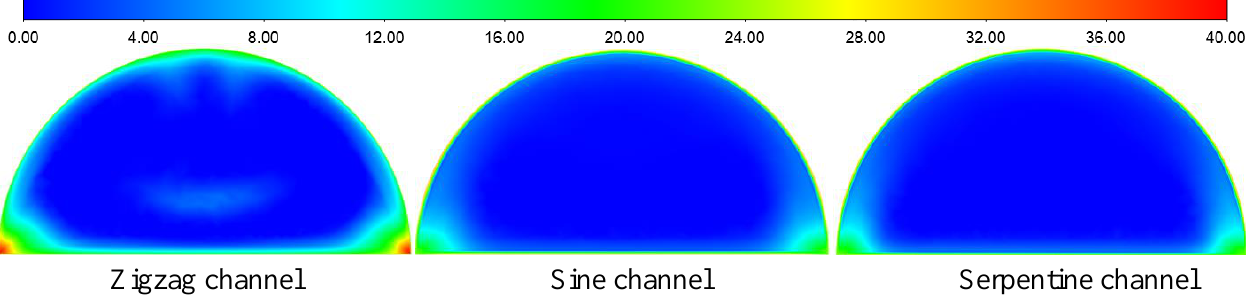
Figure 22. The velocity distributions and temperature contours in different tunnels at the same location ( Re in = 2500, A = tan 57.5° , q = 1 kW/m 2 , and 29% Xe; cross-section ID_3 in Figure 17). ( a ) Zig channel. ( b ) Sine channel. ( c ) Serpentine channel.